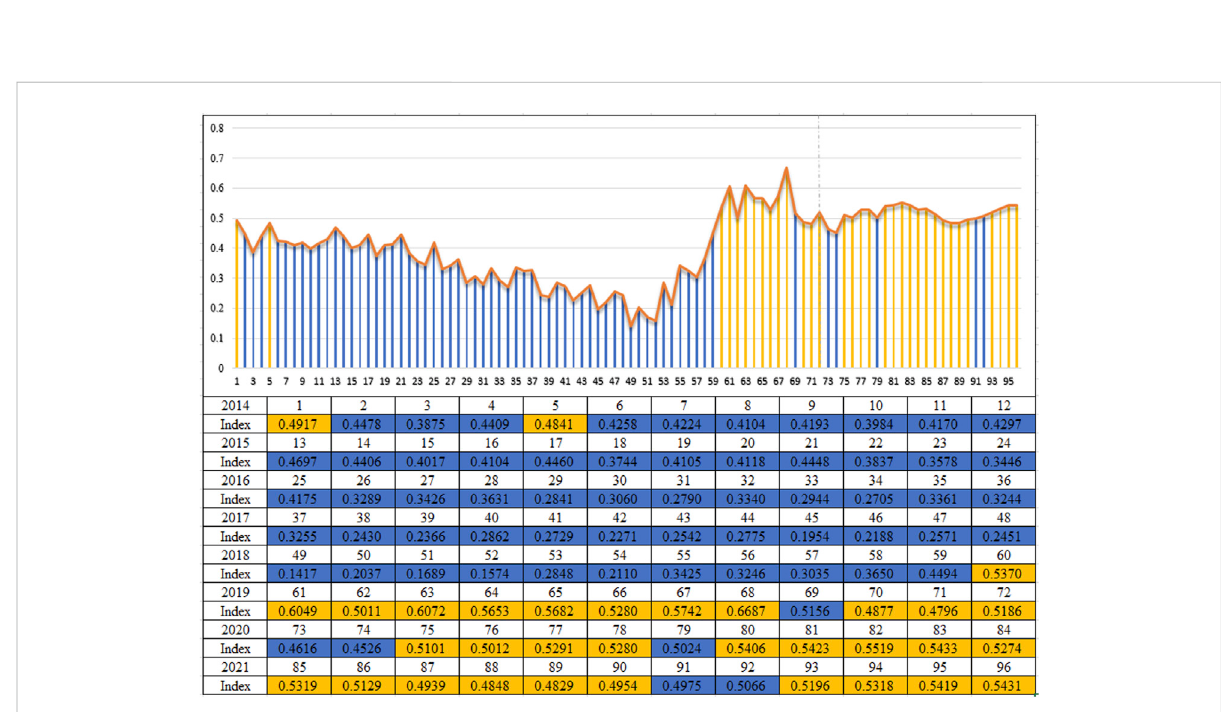
FIGURE 12 The monthly aggregated warning indexes for Changning play from 2014 to